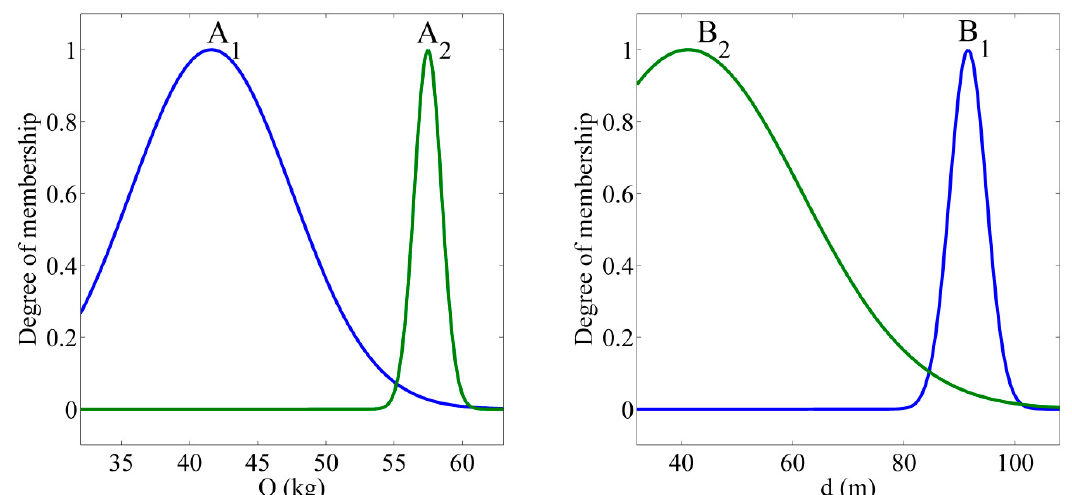
Figure 7. Membership functions for the prediction model peak particle velocity (PPV) for input variable Q , and for d .